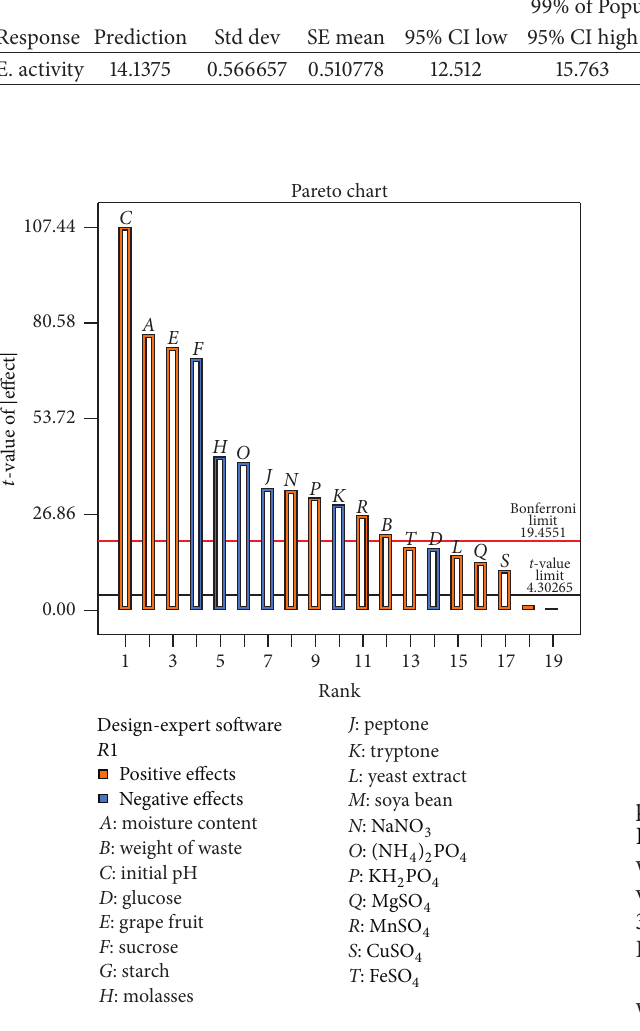
Figure 2: Main effects of the medium constituents on A. niger naringinase production by the Plackett-Burman experimental results.